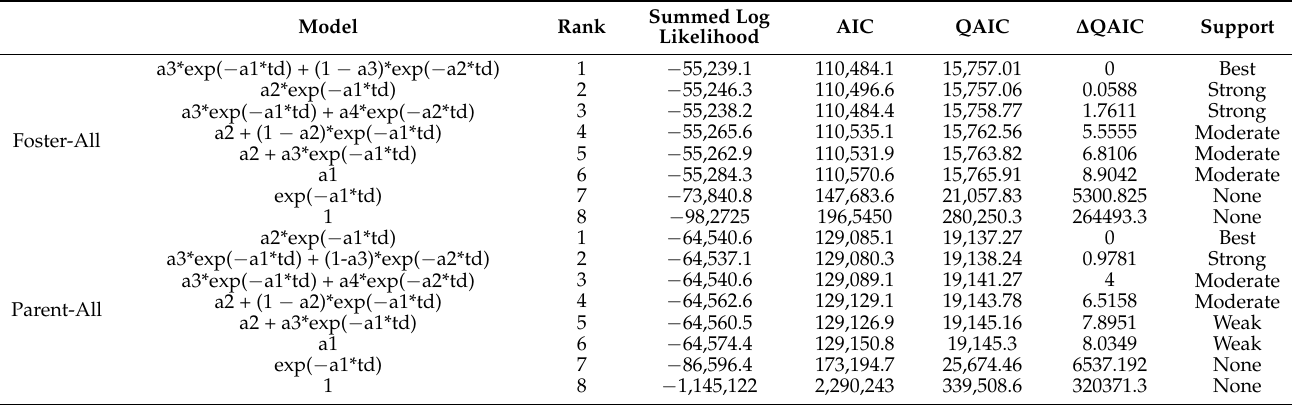
Table A9. Comparison of QAIC scores from Whitehead’s (2005) models fitted to lagged association rates. Model Rank Summed Log Likelihood AIC QAIC ∆